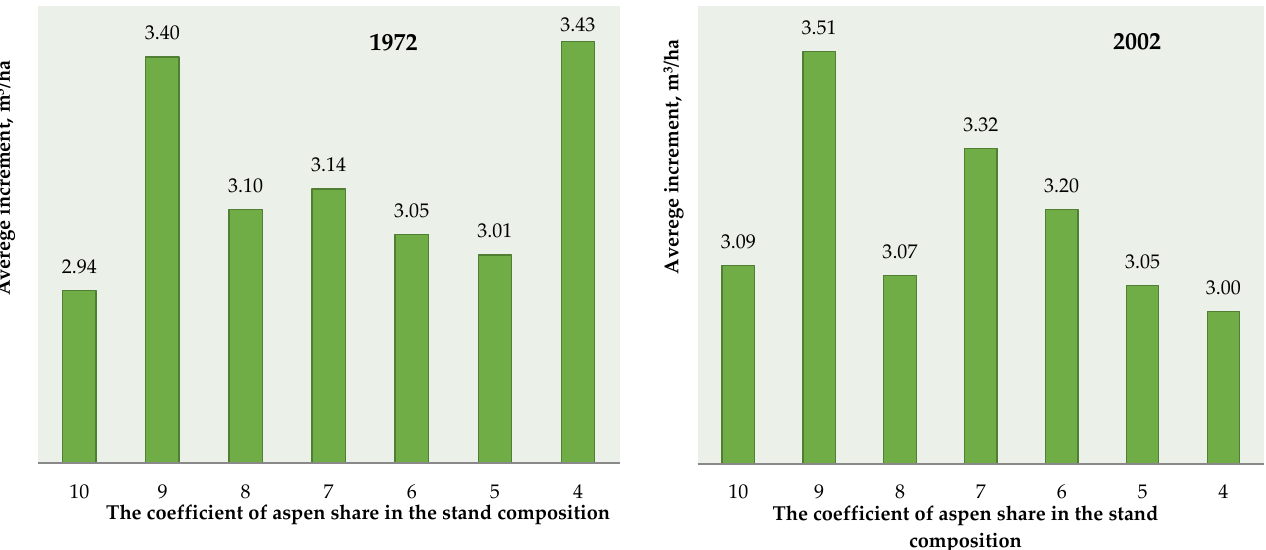
Figure 2. Correlation between the average stock increment and the coefficient of aspen share in the stand composition (1972, 2002).